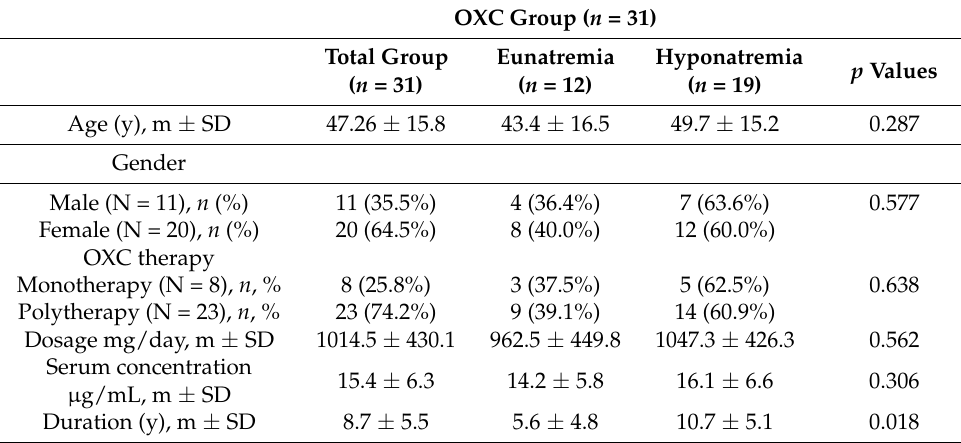
Table 2. Comparisons of demographic and clinical features between OXC- treated patients with and without hyponatremia.